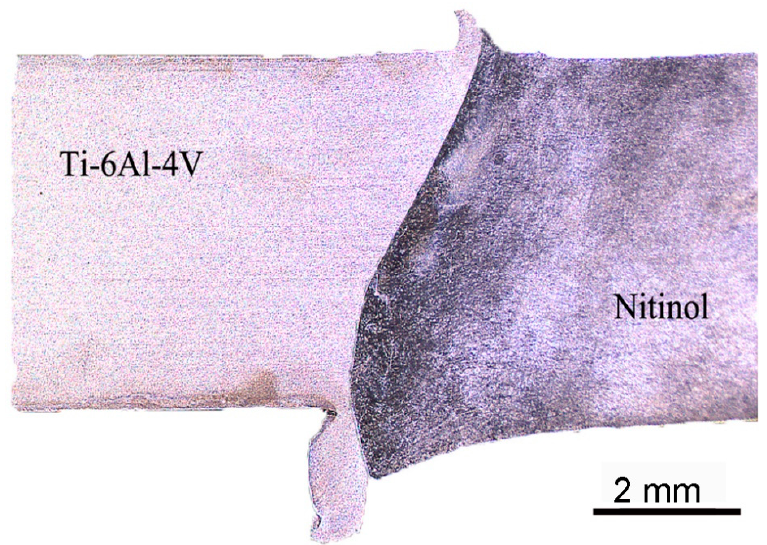
Figure 5. Macrostructure of the dissimilar linear friction welded Ti-6Al-4V/Nitinol sample showing more flash on the Ti-6Al-4V side.